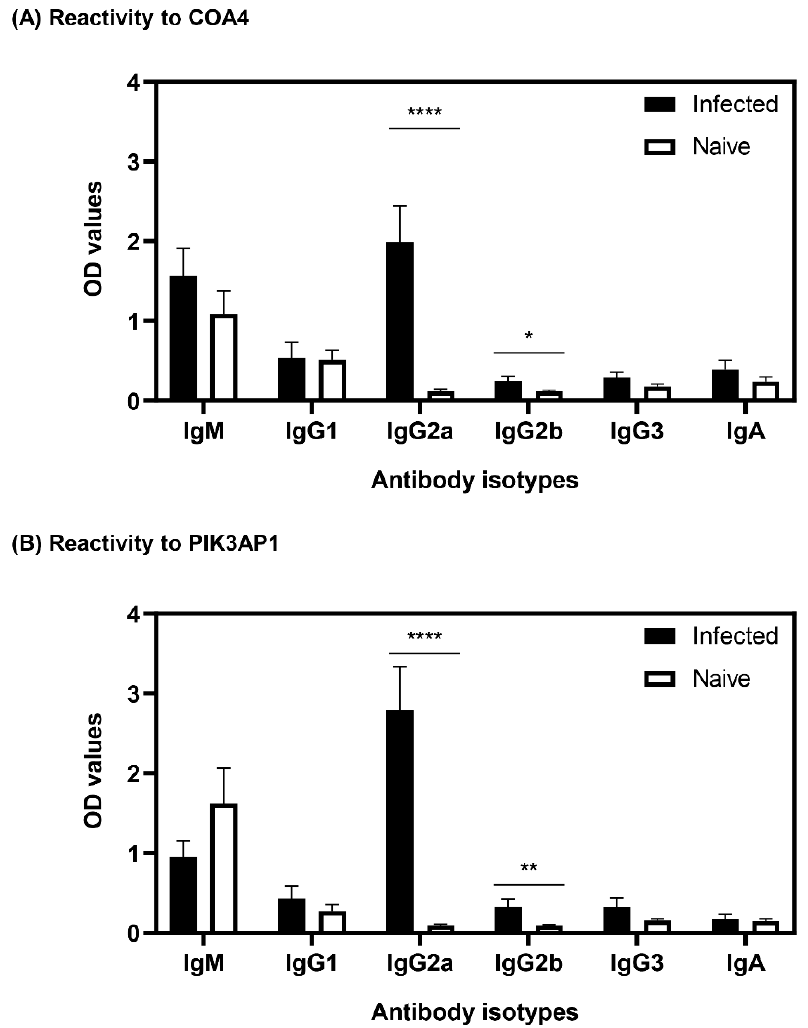
Figure 4. Antibody reactivities to COA4 and PIK3AP1 in CVB3-infected animals were predominantly of IgG2a. ( A , B ) Reactivity to COA4 and PIK3AP1. Sera harvested from A/J mice infected with or without CVB3 were diluted (1:100) and added in duplicates to plates coated with COA4 or PIK3AP1. After adding HRP-conjugated anti-mouse IgM, IgG1, IgG2a, IgG2b, IgG3, and IgA as detection antibodies and substrate, reactions developed after the addition of substrate were stopped, and the plates were read at 450 nm to obtain OD values. Mean ± SEM values representing three samples per group with each sample representing a pool of sera from 3–4 mice. Two-way ANOVA with Sidak’s test was used to determine significance between groups. * p ≤ 0.05, ** p ≤ 0.01, **** p ≤ 0.0001.